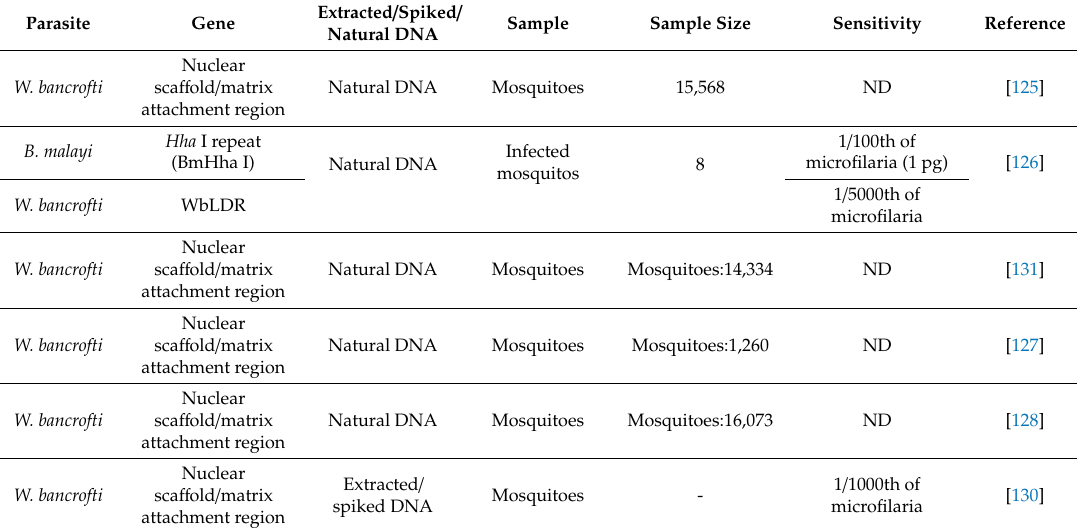
Table 11. Publications found in the US National Library of Medicine National Institutes of Health (NCBI-PubMed) reporting the standardisation of the LAMP technique as a useful tool for diagnosing lymphatic filariasis in the